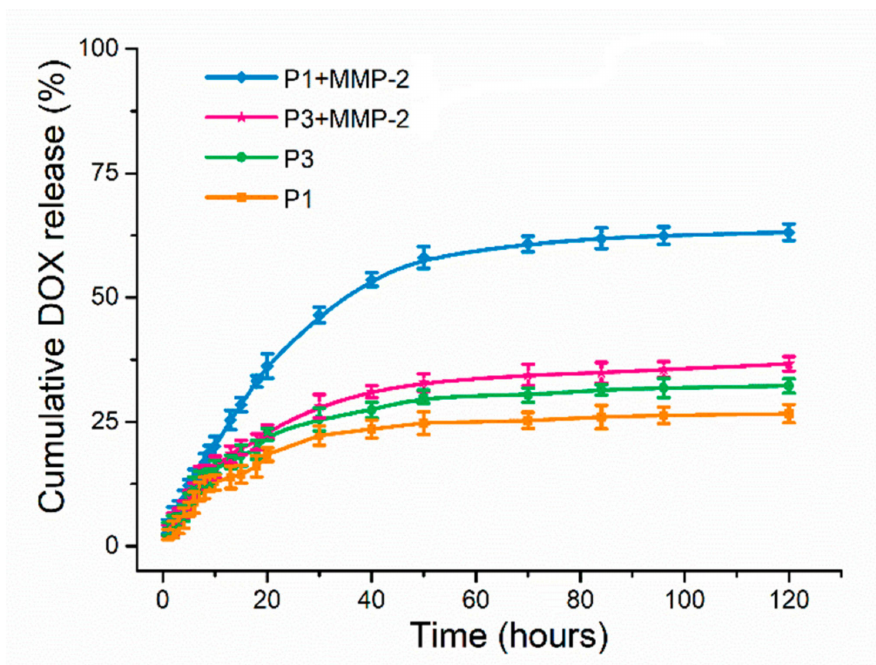
Figure 4. In vitro release of DOX from P1 and